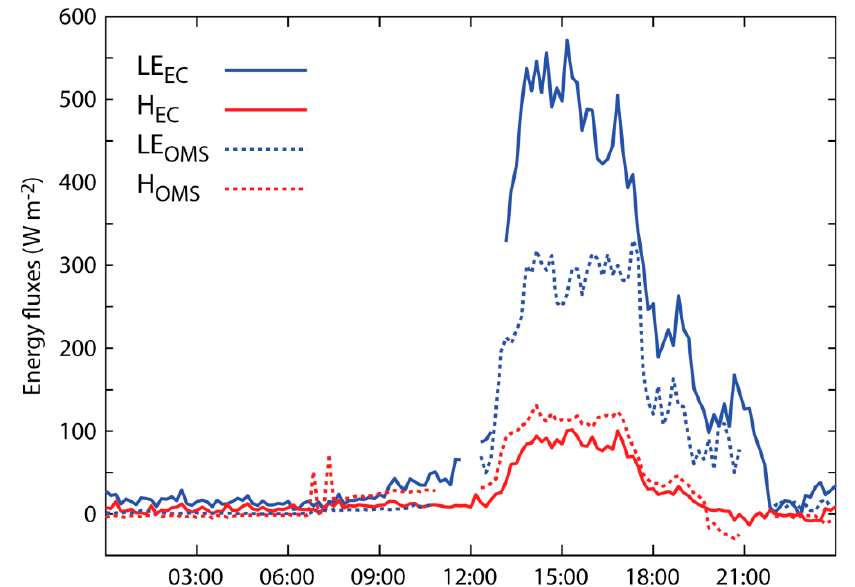
Figure 6. Latent ( LE ) and sensible ( H ) heat fluxes measured by the EC-water system and the OMS (15 November (November 15, 2018).